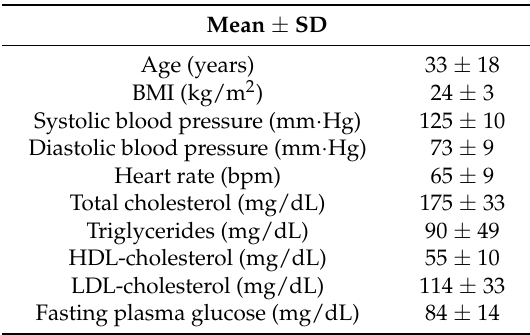
Table 1. Characteristics study population ( n =